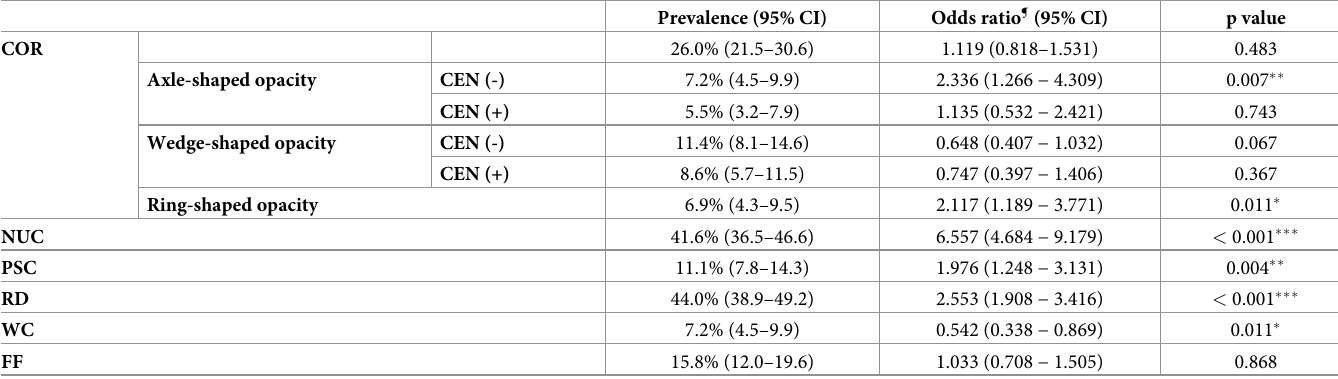
Table 6. Cataract prevalence and risk in eyes with pterygium.